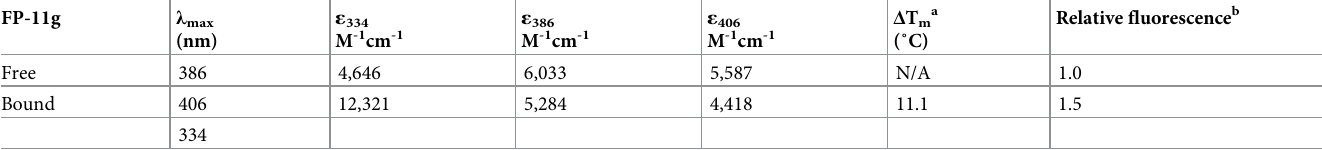
Table 3. Optical properties of FP-11g in the presence and absence of ST DNA in 1 × BPE buffer. FP-11g λ max